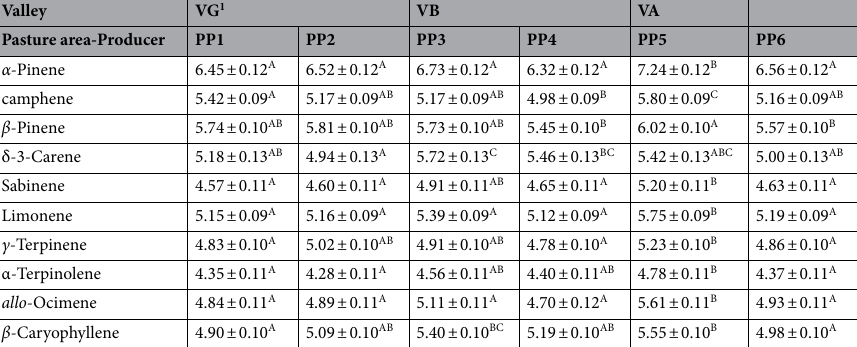
(LEUCON-F: 5 ′ -TGT CGC ATG ACA CAA AGT TAA AAG -3 ′ , LEUCON-R: 5 ′ -CAC CGC GGA TCC ATC TCT A-3 ′ ),